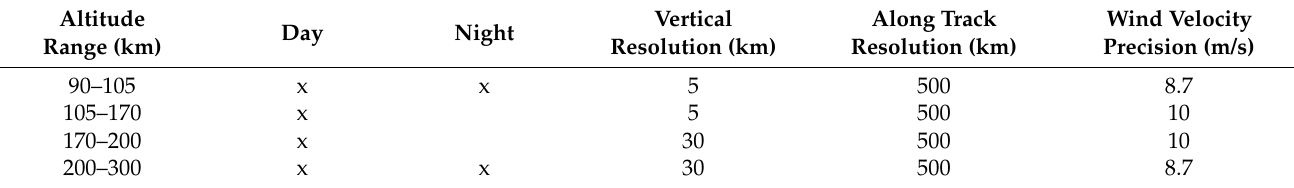
Table 1. MIGHTI measurement requirements for a single field of view of